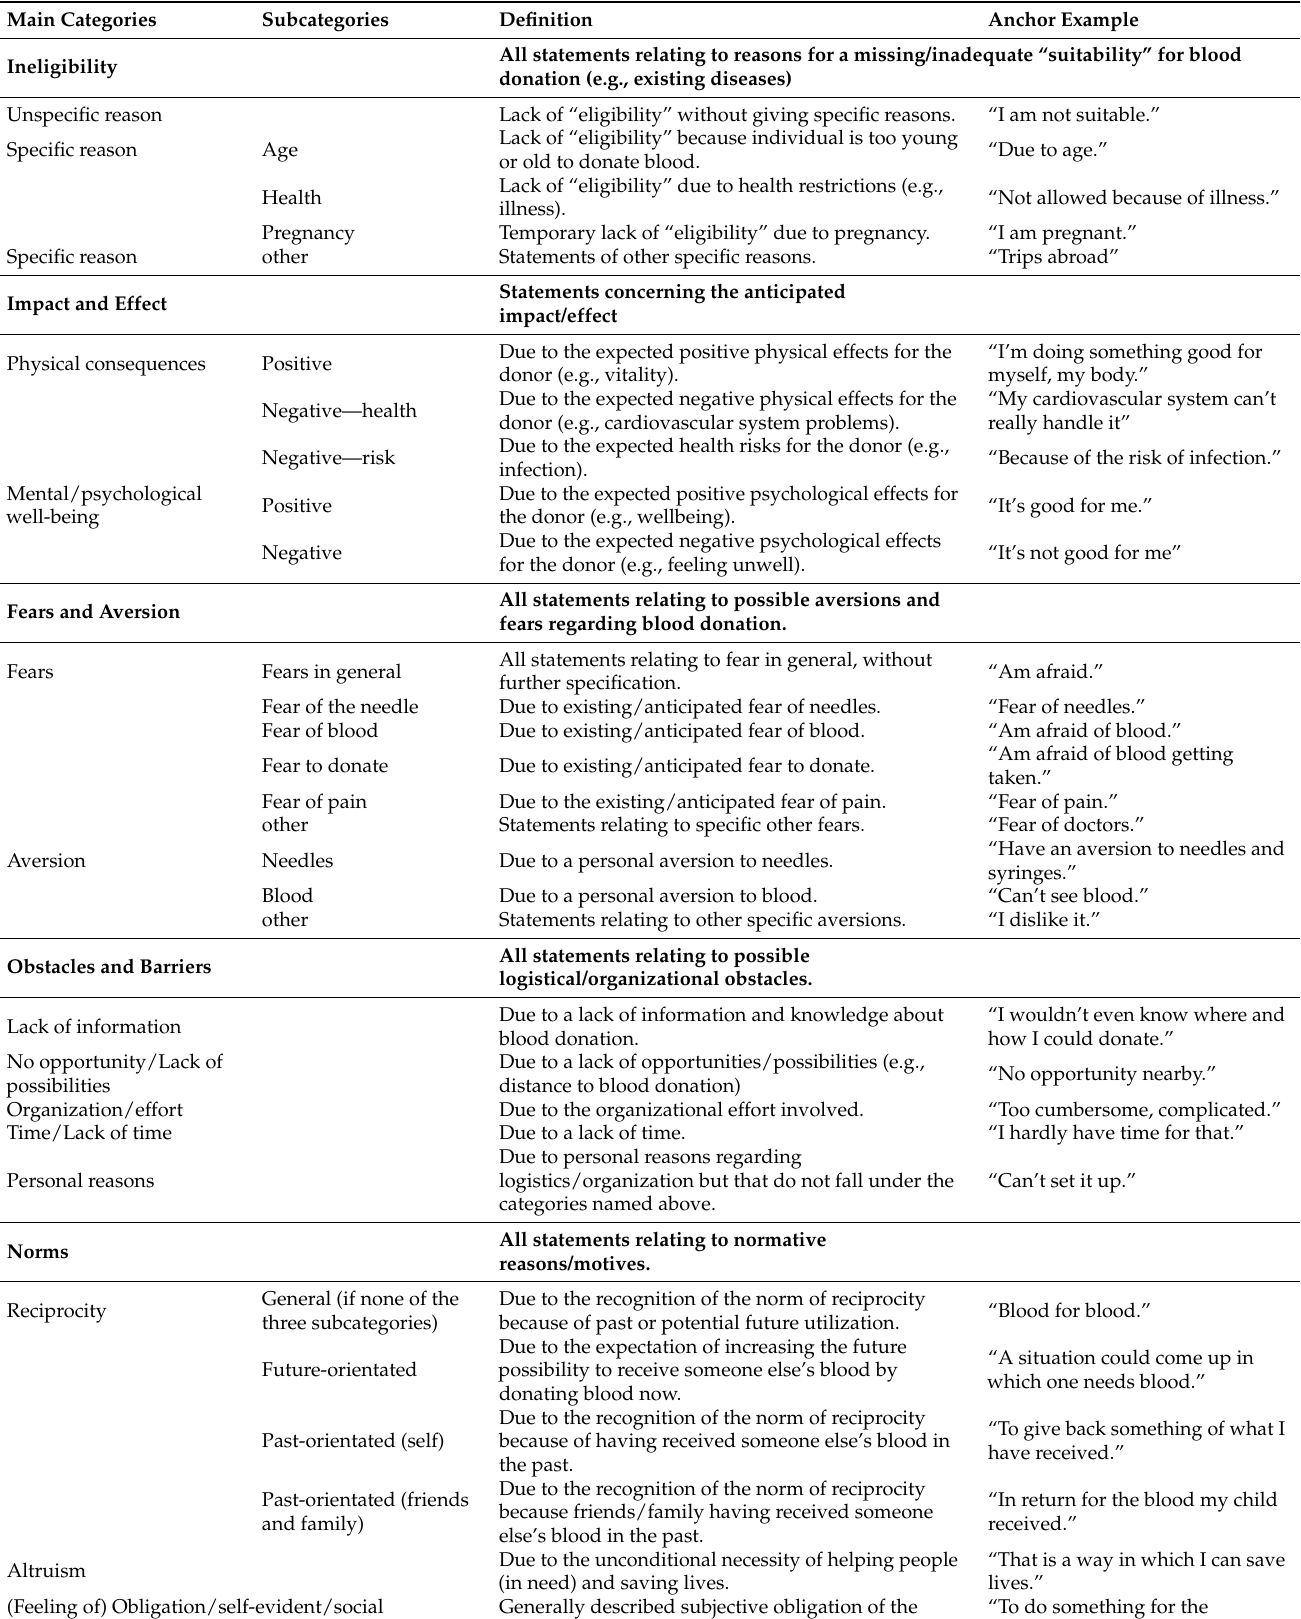
Table 3. Category system for self-reported blood donation motivators and deterrents differentiated by domains, main categories, and subcategories, including definitions and anchoring